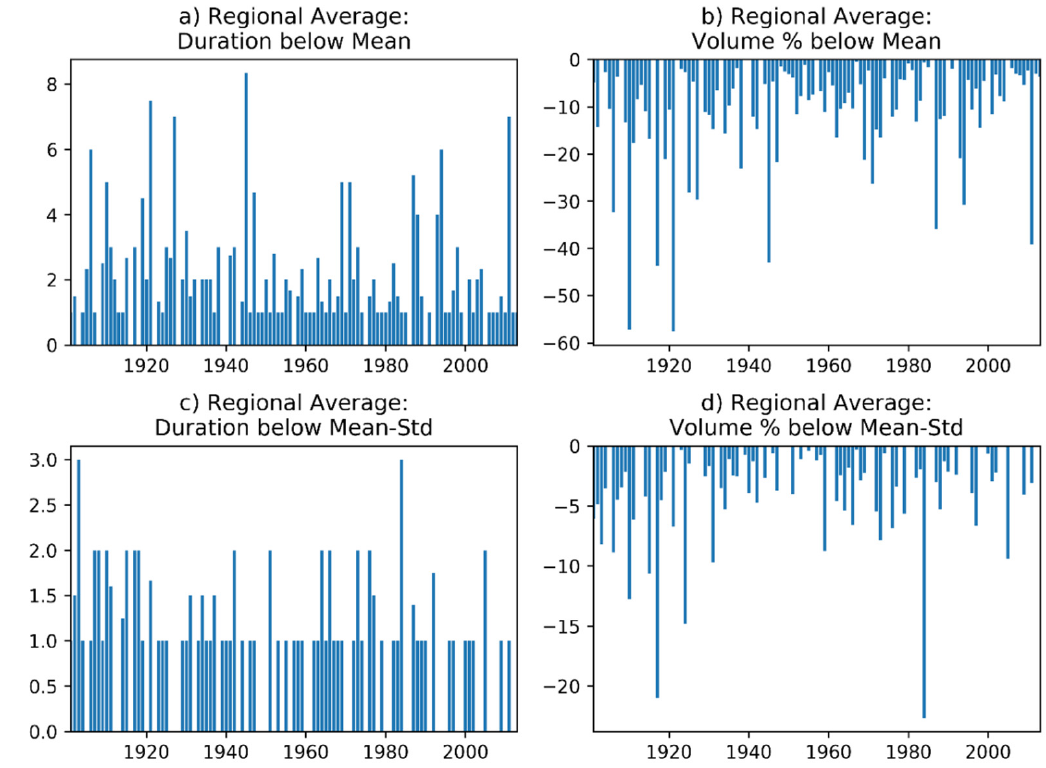
Figure 12. Regional averages of deficit duration and volume percentage for each year for the mean and MSD crossing levels, 1901–2013.